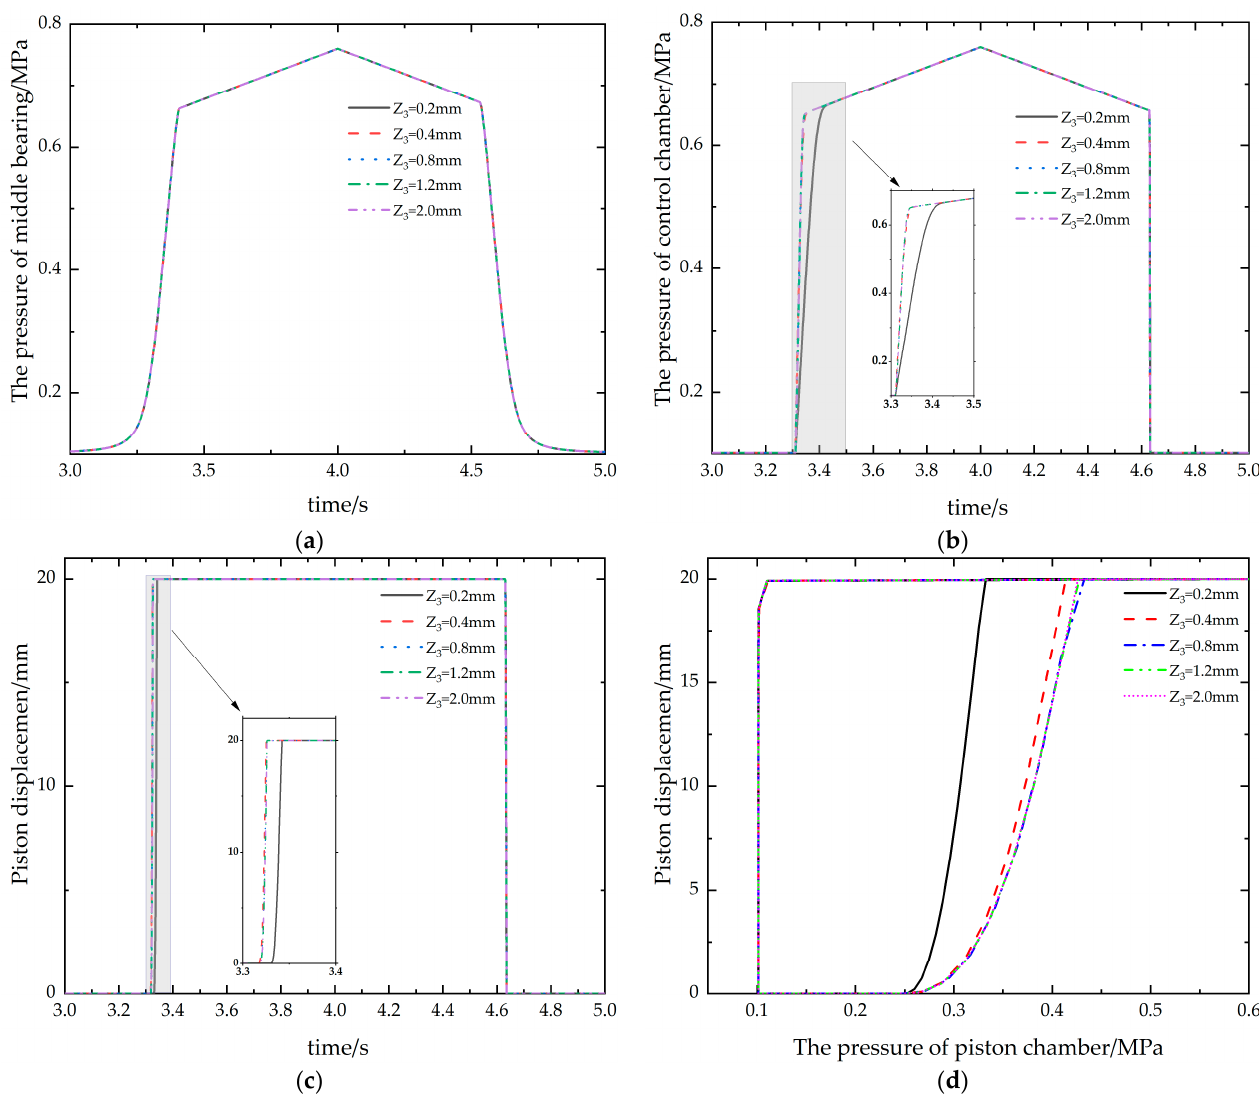
Figure 13. Opening and closing characteristics of valve with different diameters of rear orifice: ( a ) The variation law of middle bearing pressure with time; ( b ) Control of the change in cavity pressure with time; ( c ) The variation law of piston displacement with time; ( d ) The variation of piston displacement with pressure in control chamber.